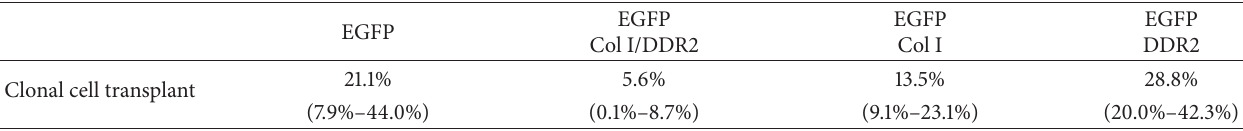
Table 4: HSCs give rise to lung